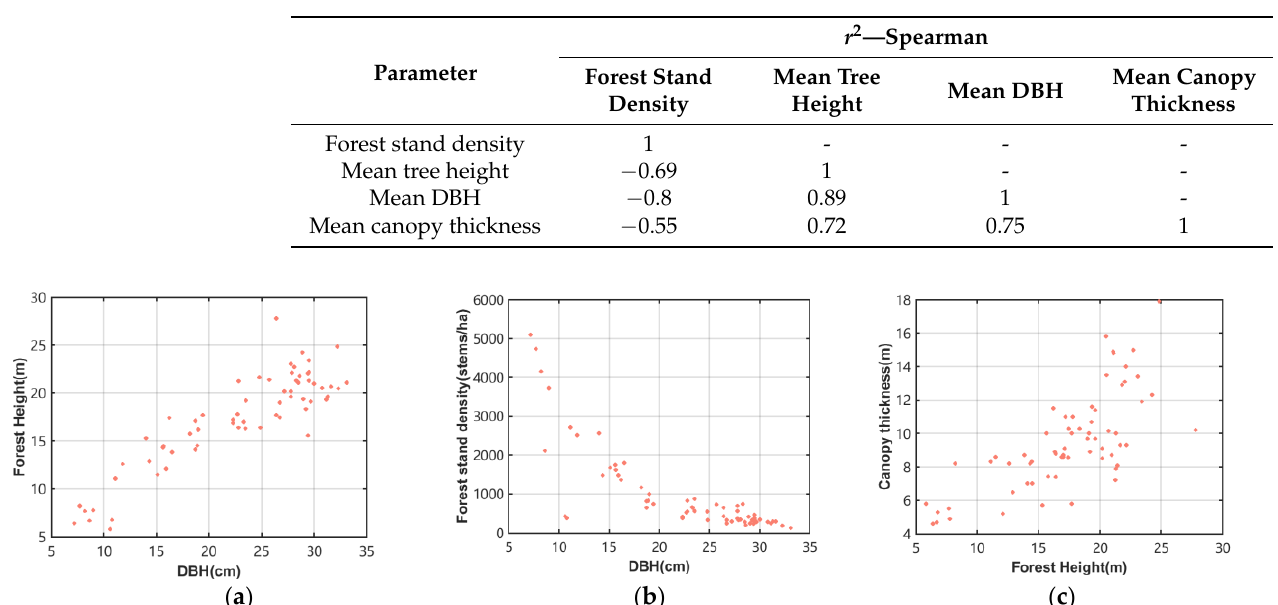
Table 2. Correlation coefficients between the biophysical forest parameters (forest stand density, mean tree height, mean DBH, mean canopy thickness), measured and derived at the stand level.